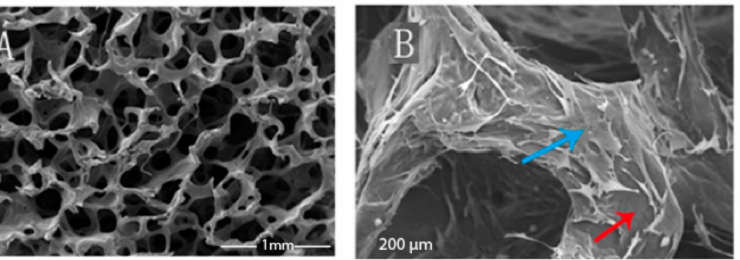
Figure 11. SEM micrographs of human porous bone tissue at low ( A ) and high magnifications ( B ) with osteoblast cell adhesion and spread (red and blue arrows